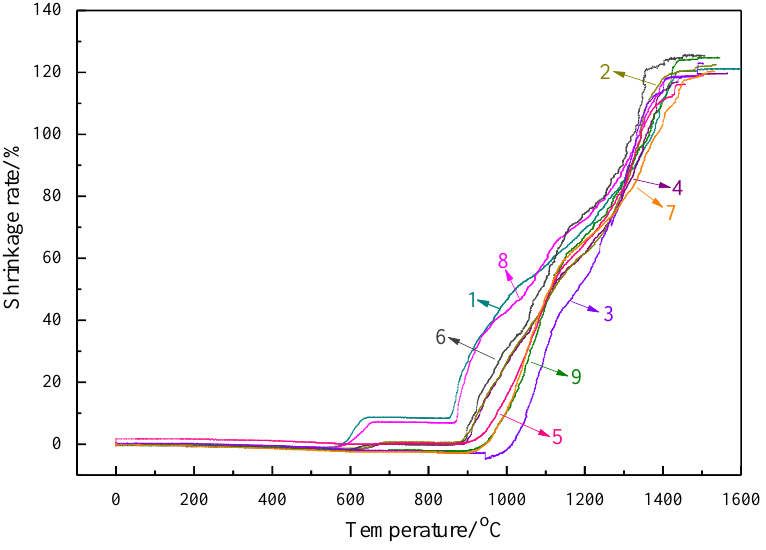
Figure 4. Shrinkage graph of ludwigite sinter.